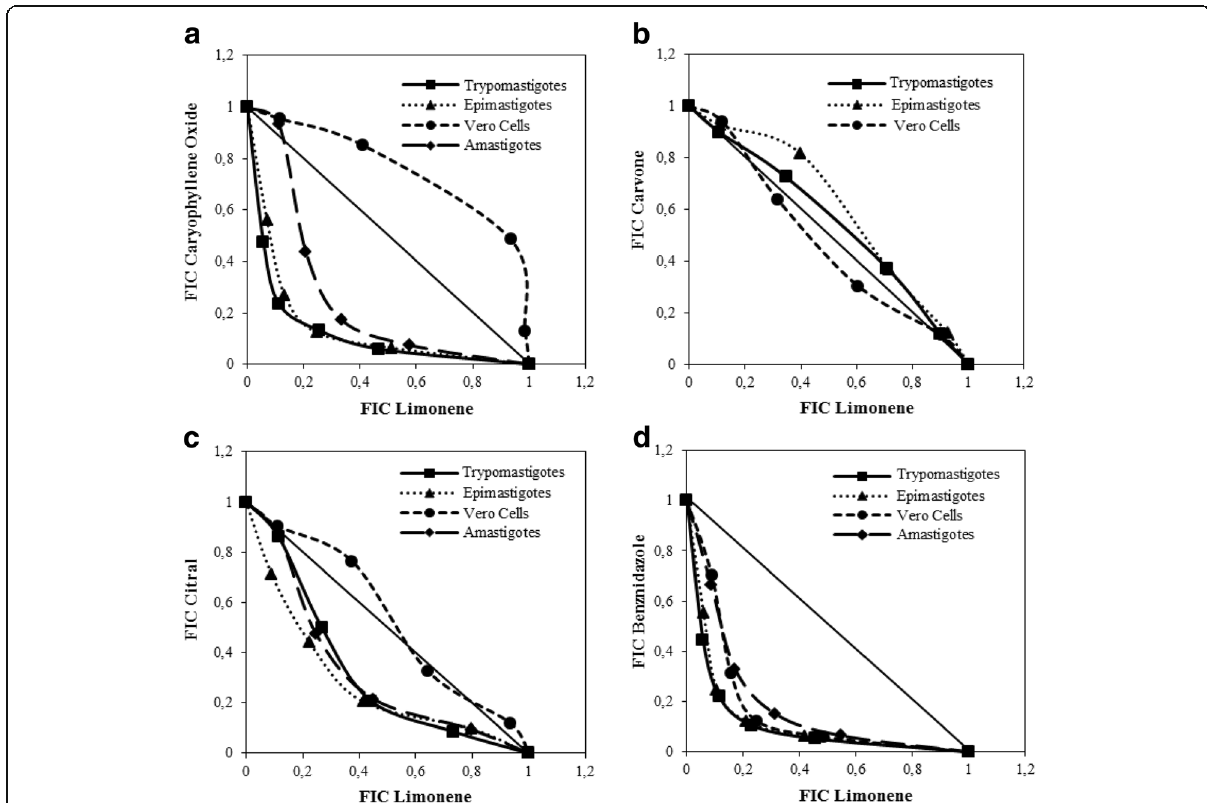
Fig. 3 Pharmacological interaction isobolograms among major terpenes of the Citral and Carvone chemotype L. alba essential oils: a limonene with caryophyllene oxide; b limonene with carvone; c limonene with citral; and d limonene with Benznidazole (BNZ). The interaction tests were performed on Epimastigotes, Trypomastigotes and Amastigotes of T. cruzi and Vero cells. Dotted lines correspond to an additive effect; points below, on, and above line indicate a synergistic, additive, and antagonistic effect,